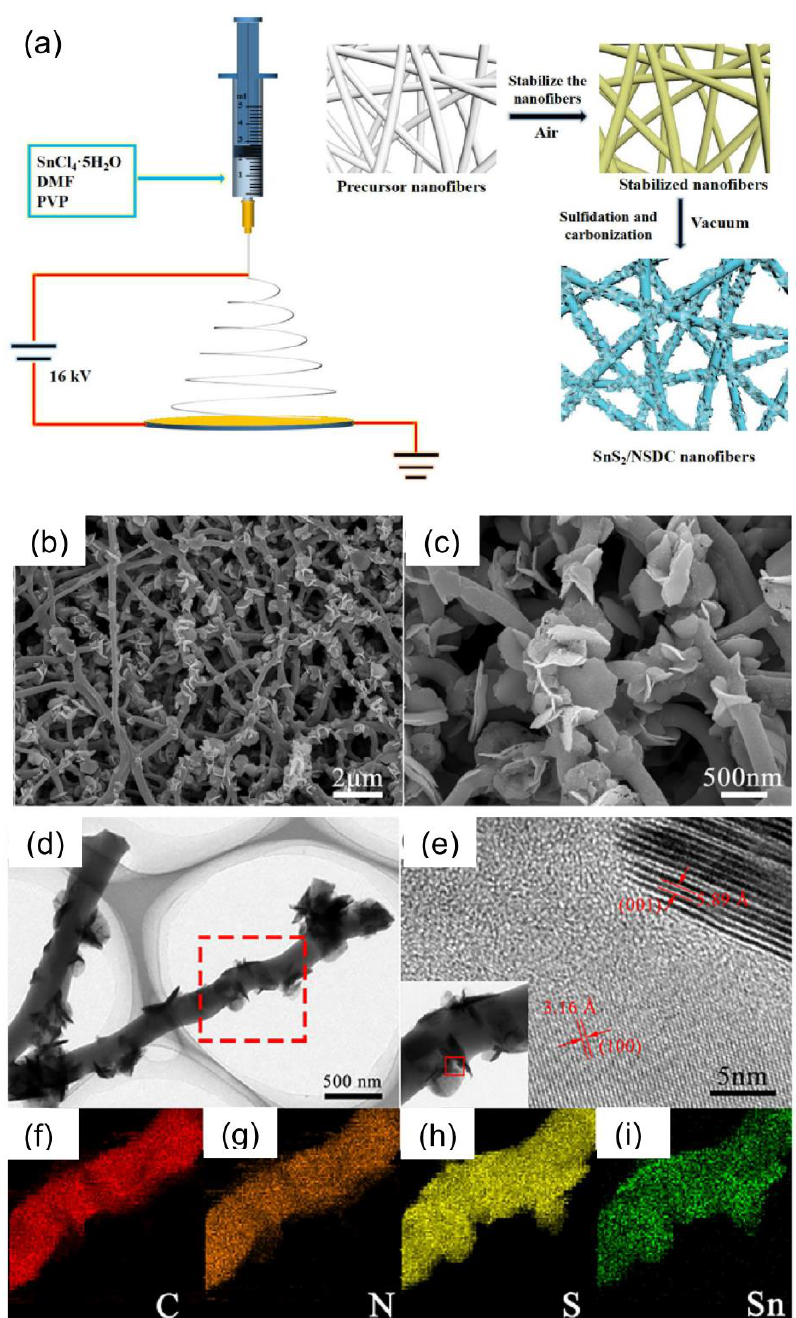
Figure 15. ( a ) Schematic illustration of the preparation process for SnS 2 /NSDC (N,S-doped dual-doped carbon) fibers. ( b,c ) Different magnification FE-SEM and ( d , e ) TEM images of the fibers. ( f − i ) EDX elemental mapping of the area, marked by the red dotted rectangular in the image (d), for (f) C, ( g ) N, ( h ) S, and ( i ) Sn components (reproduced from reference [139] with permission. Copyright 2018, Elsevier).